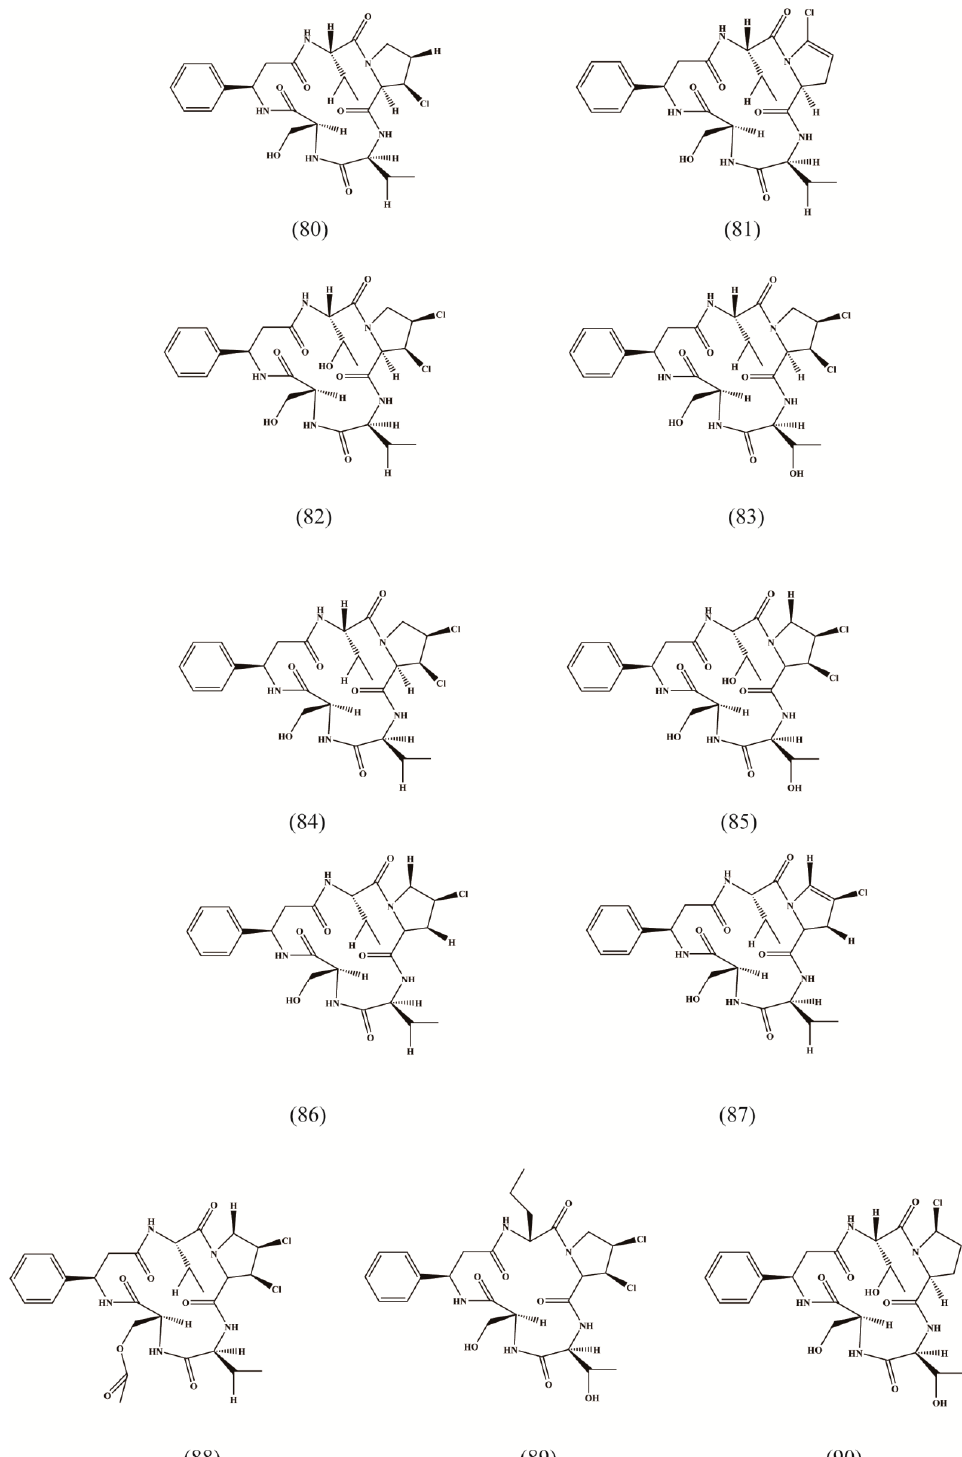
Figure 4. Structures of peptides isolated from Radix Asteris.